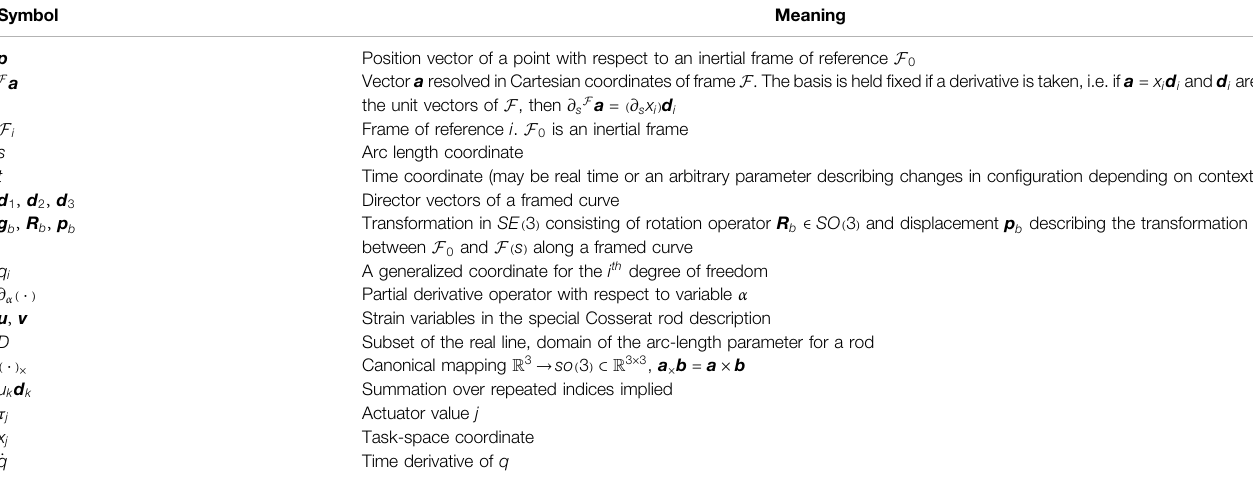
TABLE 1 | Nomenclature used in this article. Symbol Meaning p Position vector of a point with respect to an inertial frame of reference F 0 F a